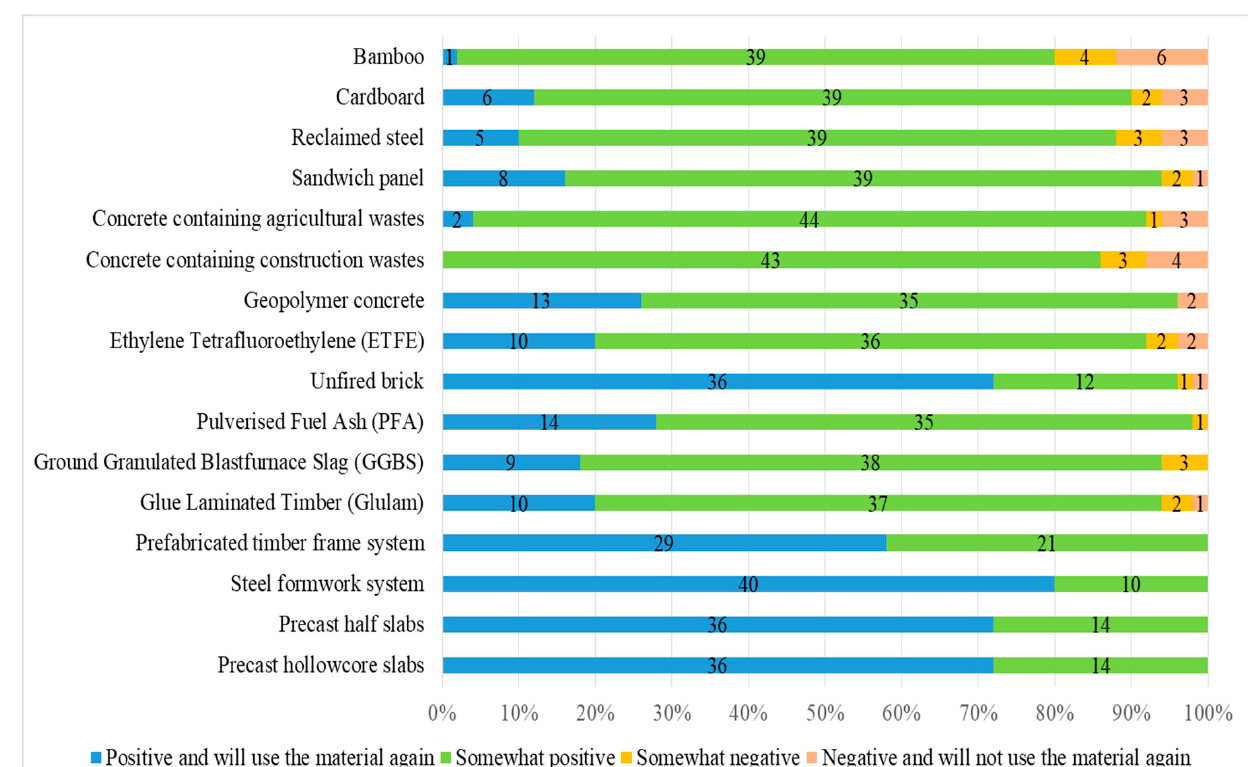
Figure 2. Experience in using alternative materials. Table 8. One-way ANOVA of the current factors encouraging the use of alternative